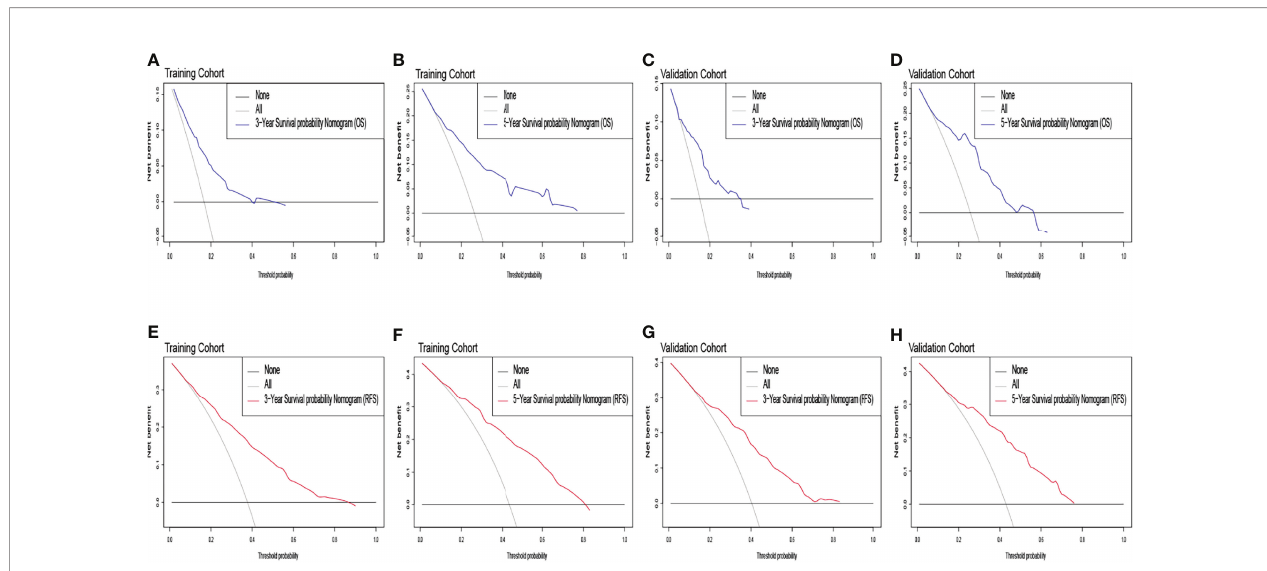
FIGURE 4 | The overall survival decision curve in the training cohort [ (A) 3 years; (B) 5 years] and the validation cohort [ (C) 3 years; (D) 5 years]. The recurrence-free survival decision curve in the training cohort [ (E) 3 years; (F) 5 years] and the validation cohort [ (G) 3 years; (H) 5 years].